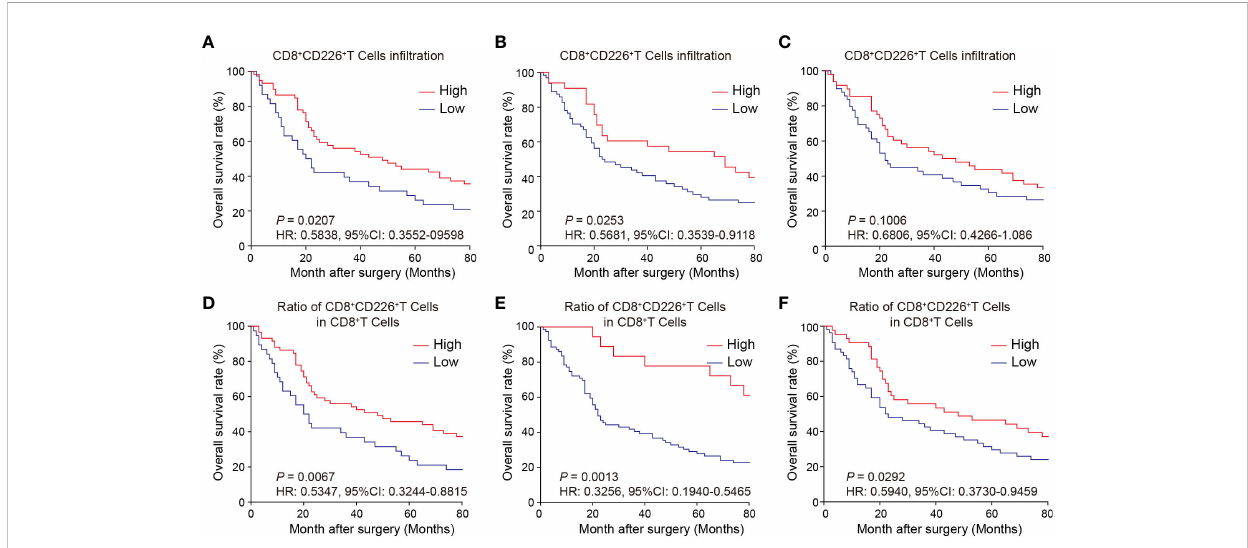
FIGURE 3 Prognostic value of CD226 + CD8 + TILs in human GC. (A – C) OS rates strati fi ed by CD8 + CD226 + TIL intensities in GC tissues (A) . whole tissues, (B) epithelial cell region, (C) stromal cell region). (D – F) OS rates strati fi ed by the ratio of CD8 + CD226 + TILs in CD8 + TILs in GC tissues (D) . whole tissues, (E) epithelial cell region, (F) stromal cell region).